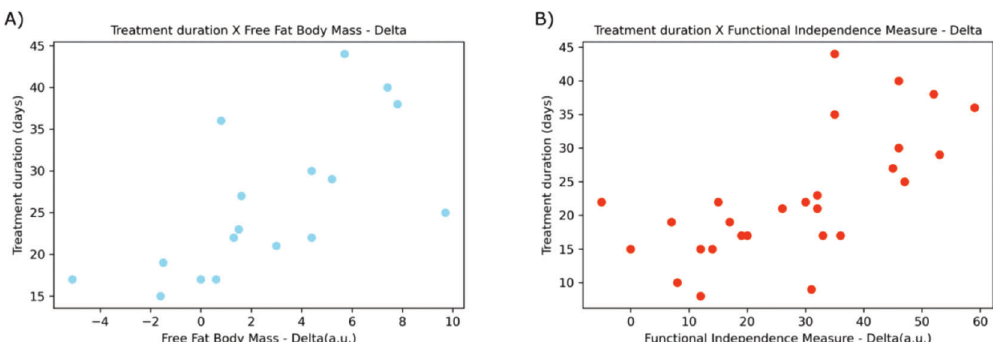
Figure 1 - Scatterplots displaying the correlation between A) treatment duration and fat-free body mass, and B) treatment duration and Functional Independence Measure. a.u., arbitrary